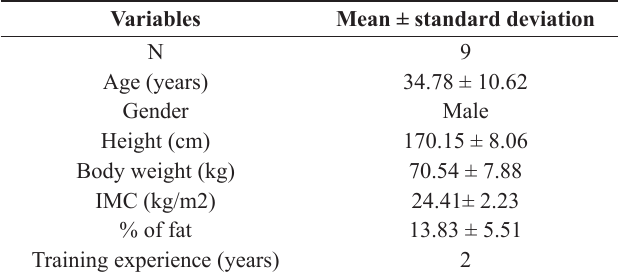
Table 1. Characterization of the study